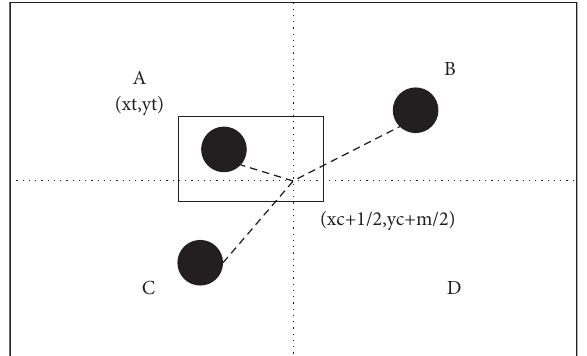
Figure 3: Schematic diagram of step 2.